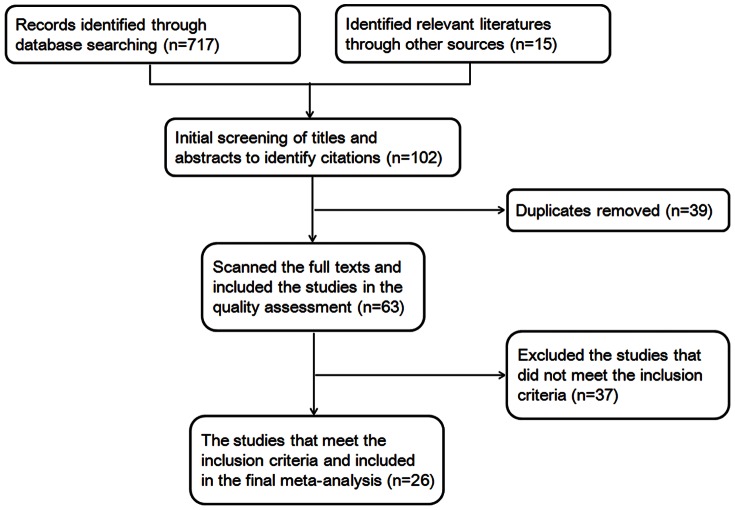
Flow chart showing study selection process for the meta-analysis.